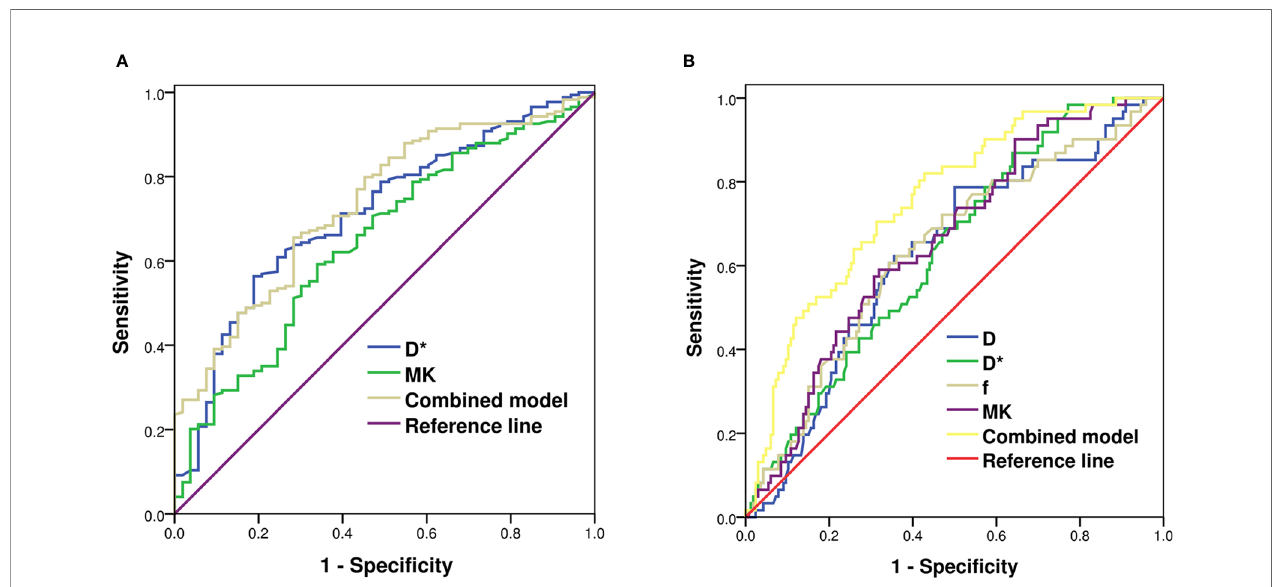
FIGURE 3 | ROC analysis of IVIM and DKI parameters in predicting Nottingham index (A) and Ki-67 (B) of breast cancer. ROC, receiver operating characteristic; IVIM, intravoxel incoherent motion; DKI, diffusion kurtosis imaging.